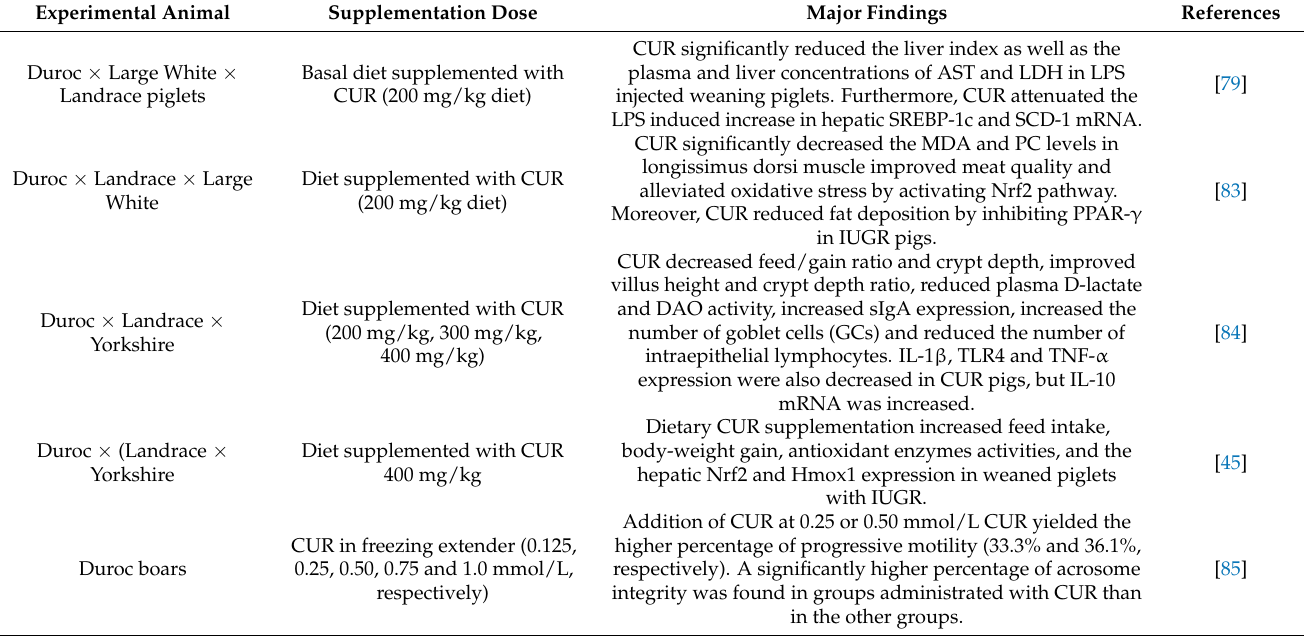
Table 3. Application effect of CUR in pig production as a plant-derived feed